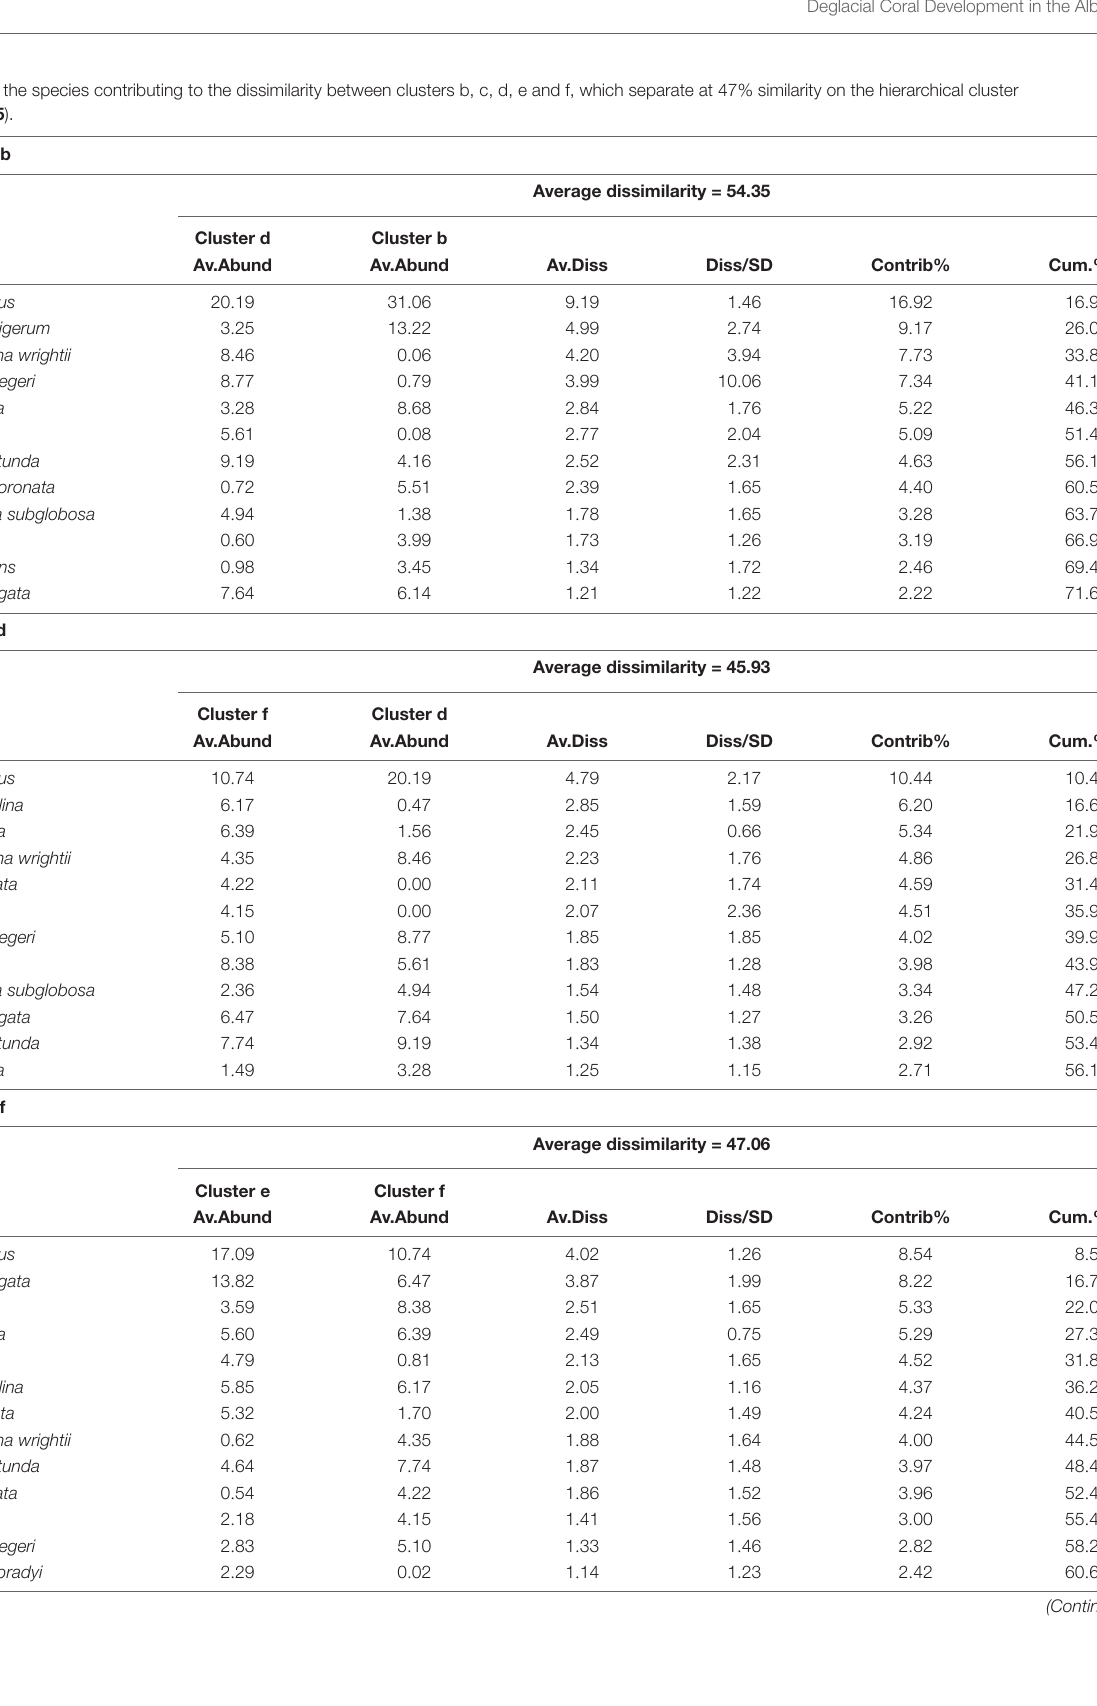
TABLE 6 | List of the species contributing to the dissimilarity between clusters b, c, d, e and f, which separate at 47% similarity on the hierarchical cluster analysis ( Figure 5 ). Clusters d and b